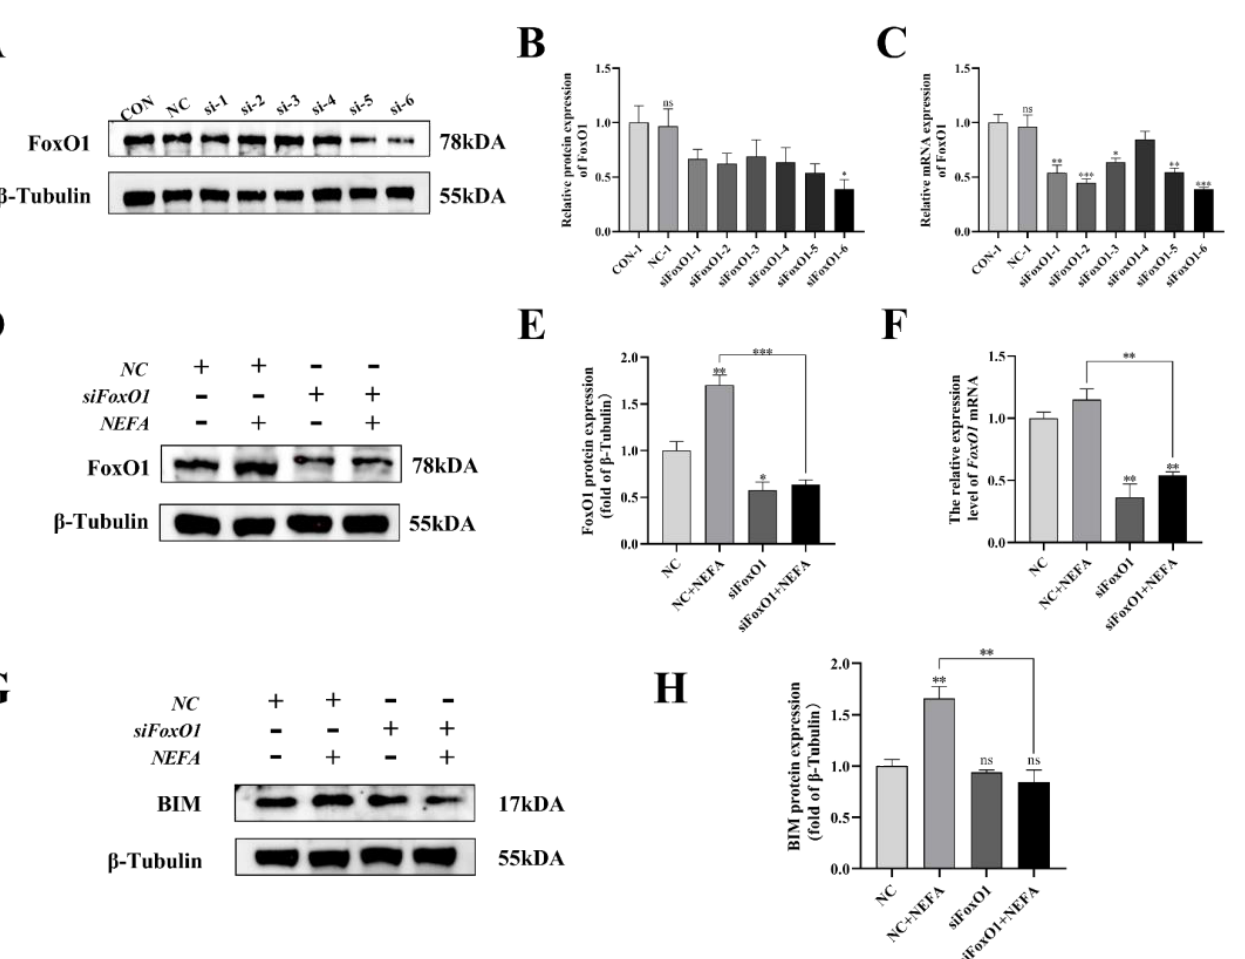
Figure 10. Screening and validation of si − RNA of FoxO1. BGCs were transfected with NC or siFoxO1 for 6 h before being treated with NEFA for 24 h. ( A – C ) Screening of si − FoxO1 by qRT − PCR and Western blot. ( D – F ) The expression of FoxO1 was determined by FoxO1 siRNA treatment. ( G , H ) Protein expression of BIM by FoxO1 siRNA treatment. The relative protein levels (performed using Image J) are quantified under the band (protein/ β − Tubulin). This experiment was repeated 3 times, and data are expressed as mean ± standard errors of the mean (SEM), * p < 0.05; ** p < 0.01; *** p < 0.001; ns, not significant.